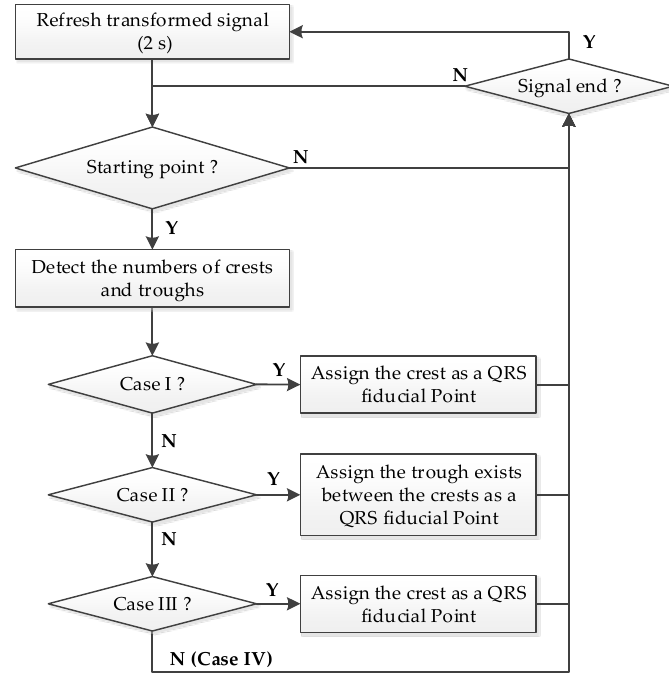
Figure 7. The proposed procedure of detecting the QRS fiducial point.